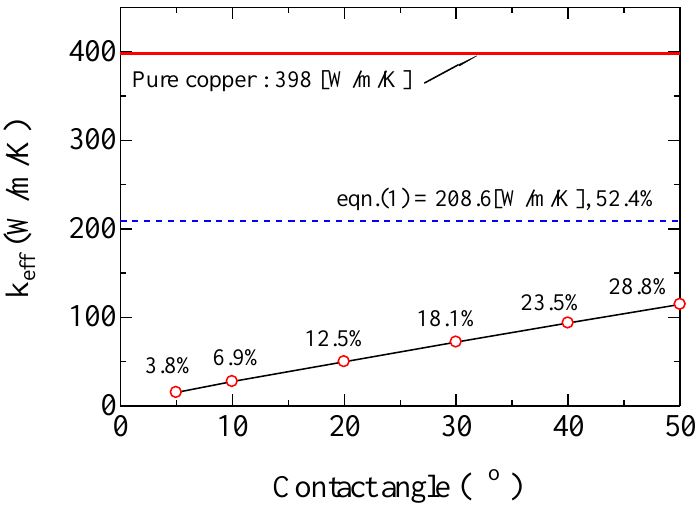
Figure 2. Effective thermal conductivity of copper sintered Figure 2. E ffective thermal conductivity of copper sintered particle.